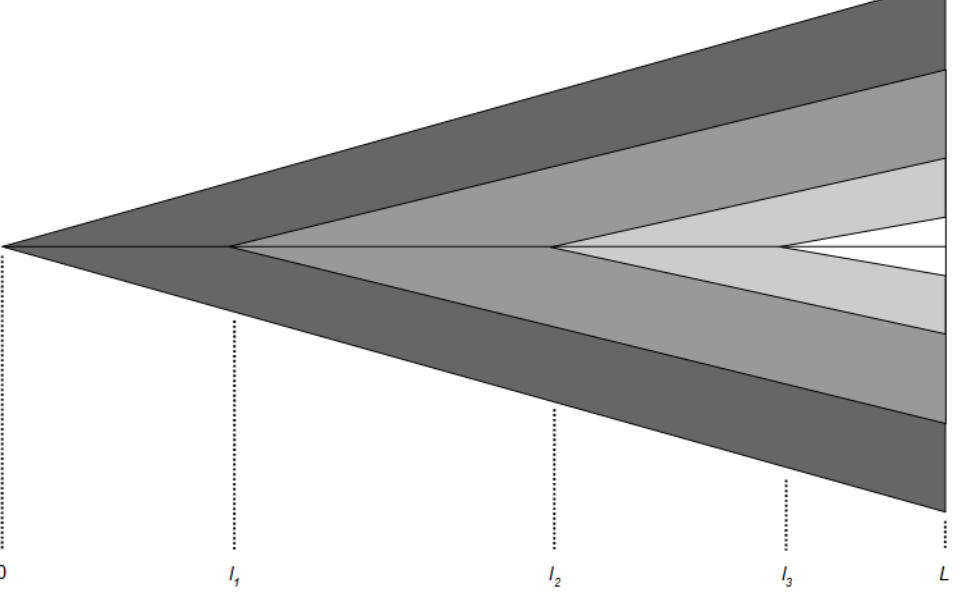
Figure 3. DSpace information content decreases as traversal approaches desired end product